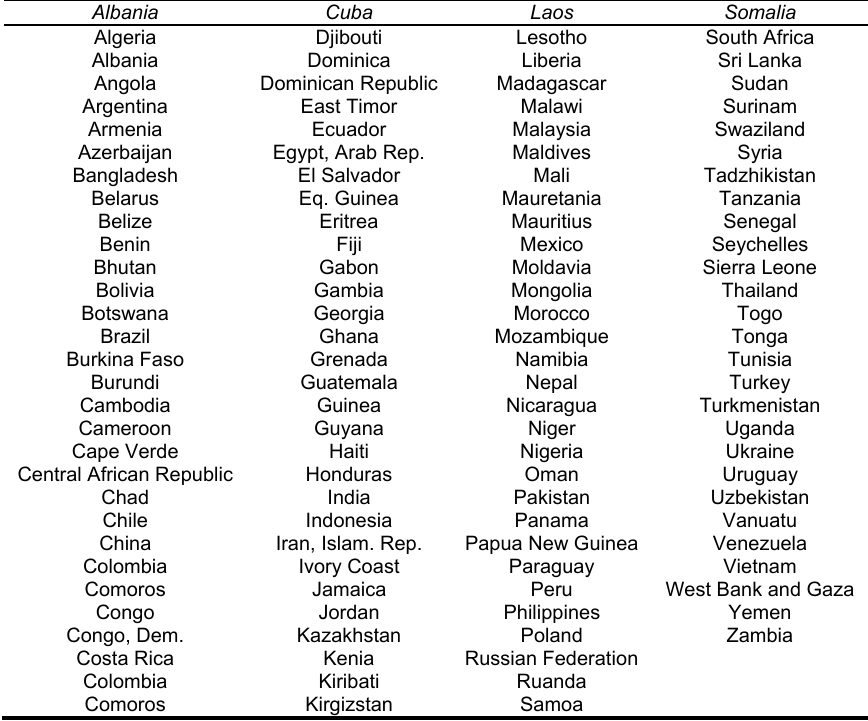
Table A1: Countries included in the empirical